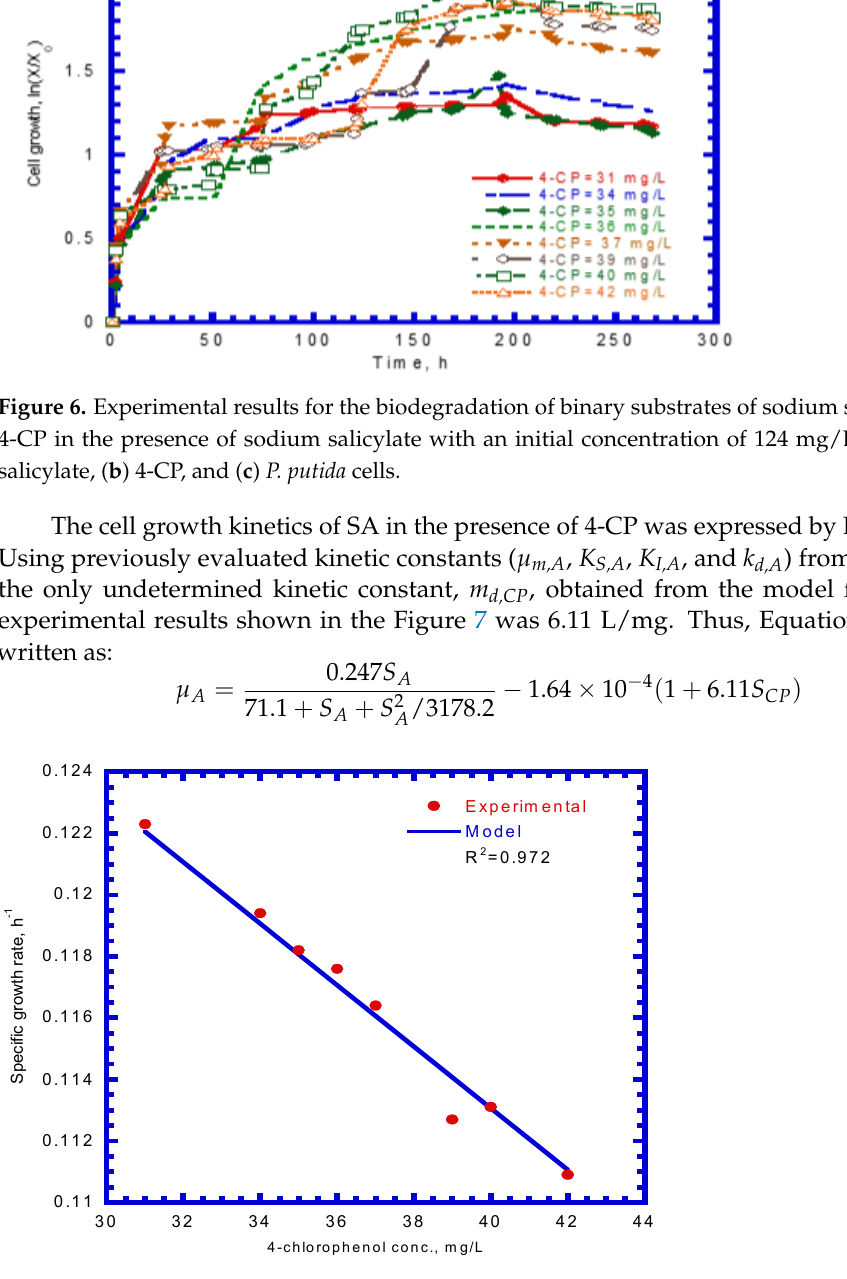
Figure 7. Model-fitted specific growth rates on binary substrates of sodium salicylate and 4-CP compared with experimental data to determine the decay constant of P. putida cells due to 4-chlorophenol ( m d,CP ).